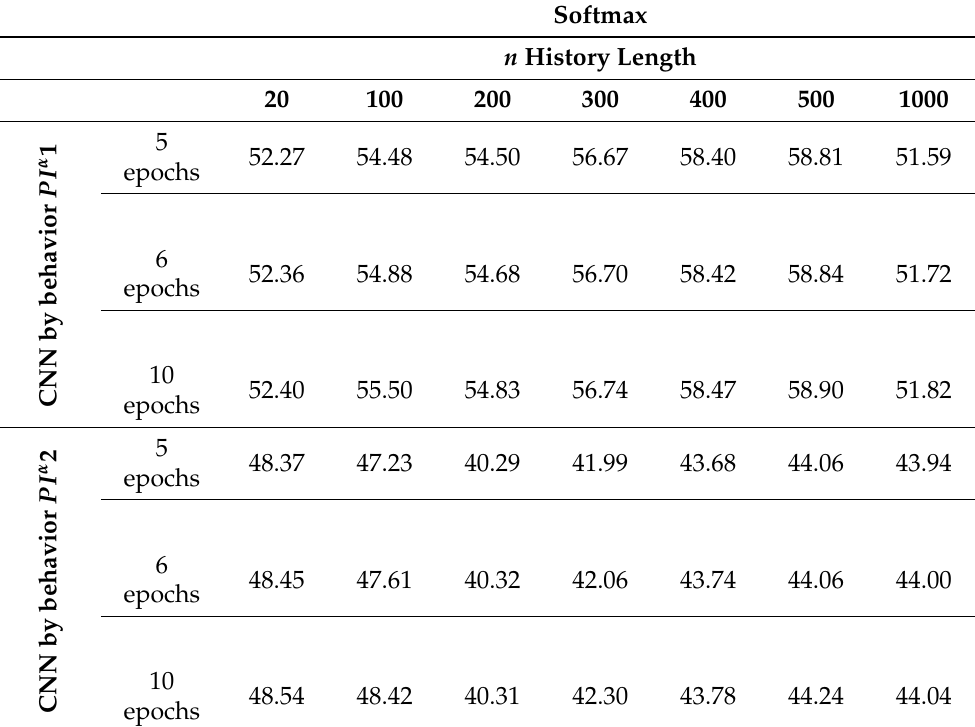
Table 3. The accuracy measurements for testing the CNN model trained on data regarding three PI α 1, PI α 2 and PI α 3 controllers, n last items in queue occupancy history taken into consideration (we used Softmax function as an activation function of the last